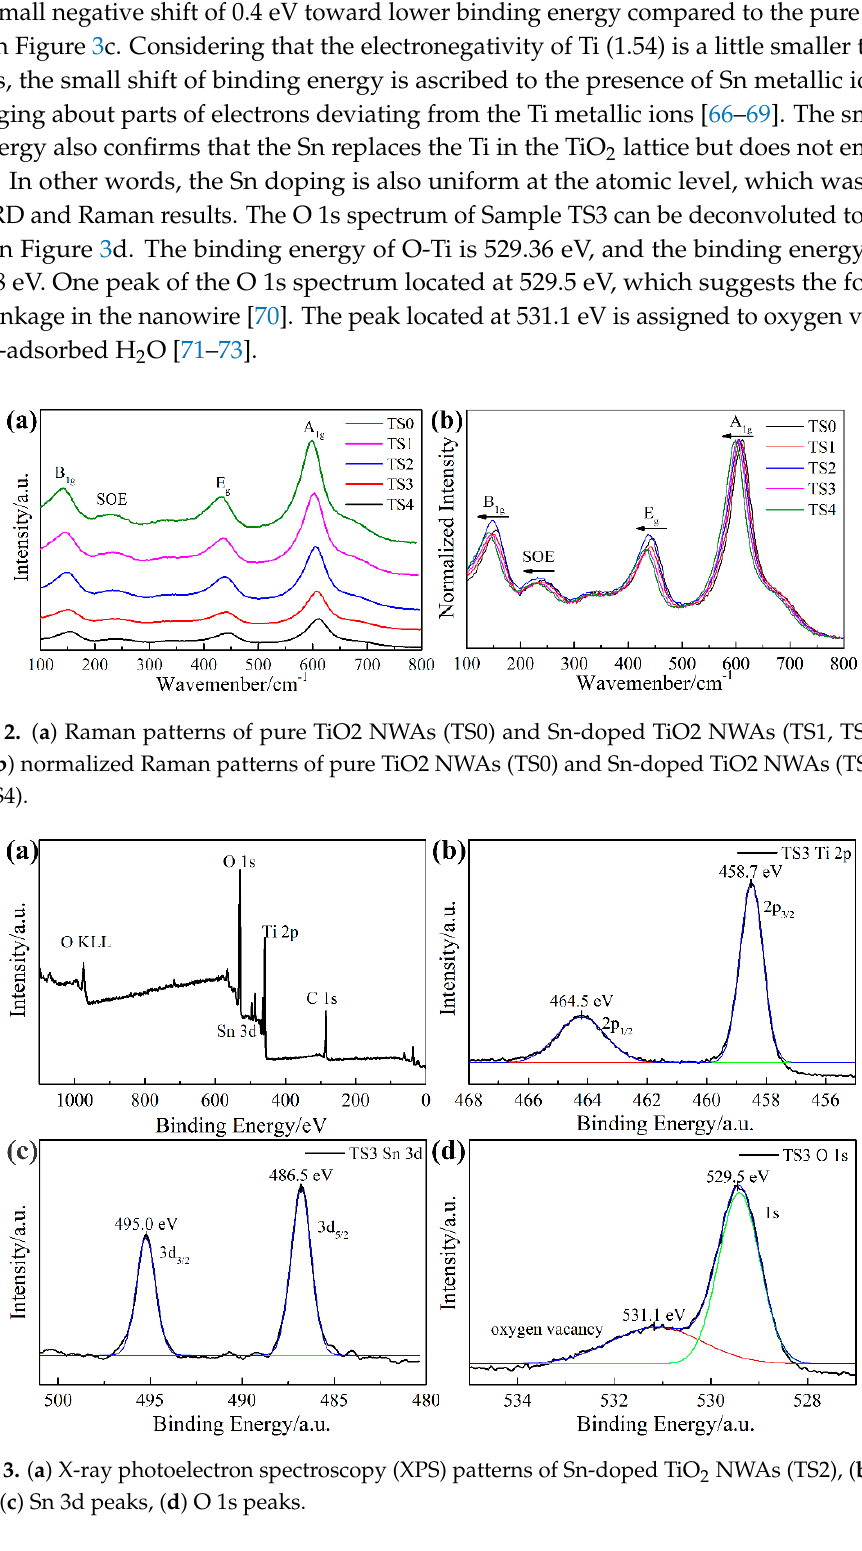
Figure 2. ( a ) Raman patterns of pure TiO2 NWAs (TS0) and Sn-doped TiO2 NWAs (TS1, TS2, TS3, TS4); ( b ) normalized Raman patterns of pure TiO2 NWAs (TS0) and Sn-doped TiO2 NWAs (TS1, TS2, TS3, TS4).